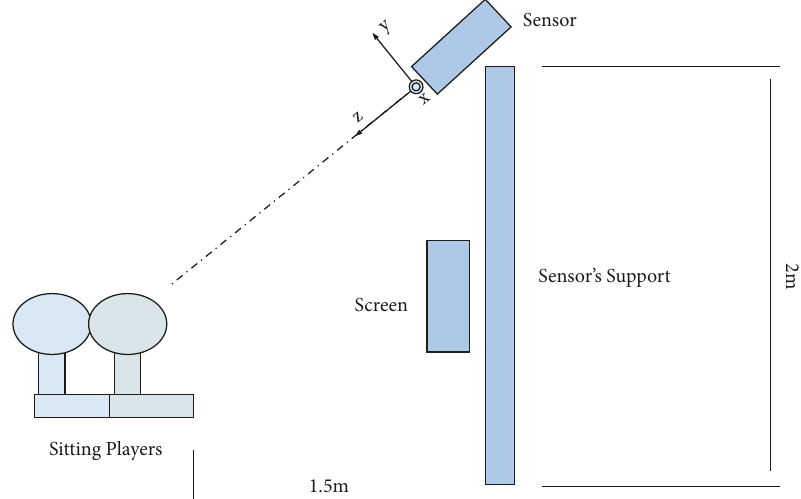
Figure 9: The Kinect mounting setup for the revised inputs. The 𝑥𝑦𝑧 coordinates for the game follow the sensor’s direction. This configuration reduces occlusions of body